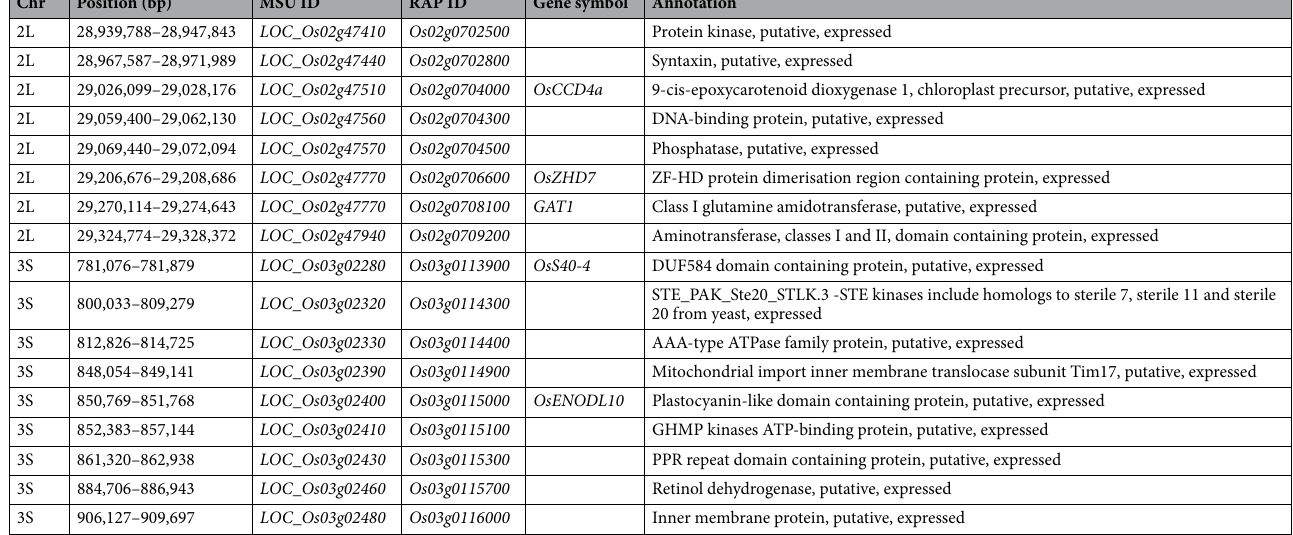
Table 2. List of candidate genes with amino acid replacements or deletions. Genes of unclear function and genes related to transposon were